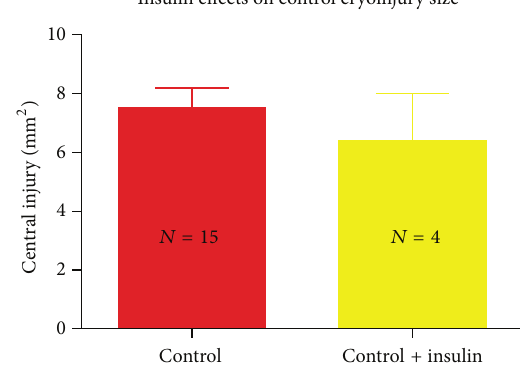
Figure 2: Cryoinjury size is unchanged in the control mouse given insulin 48hrs following cryoinjury; the epicardial area that does not take up TTC dye is unchanged in the control mouse given insulin.